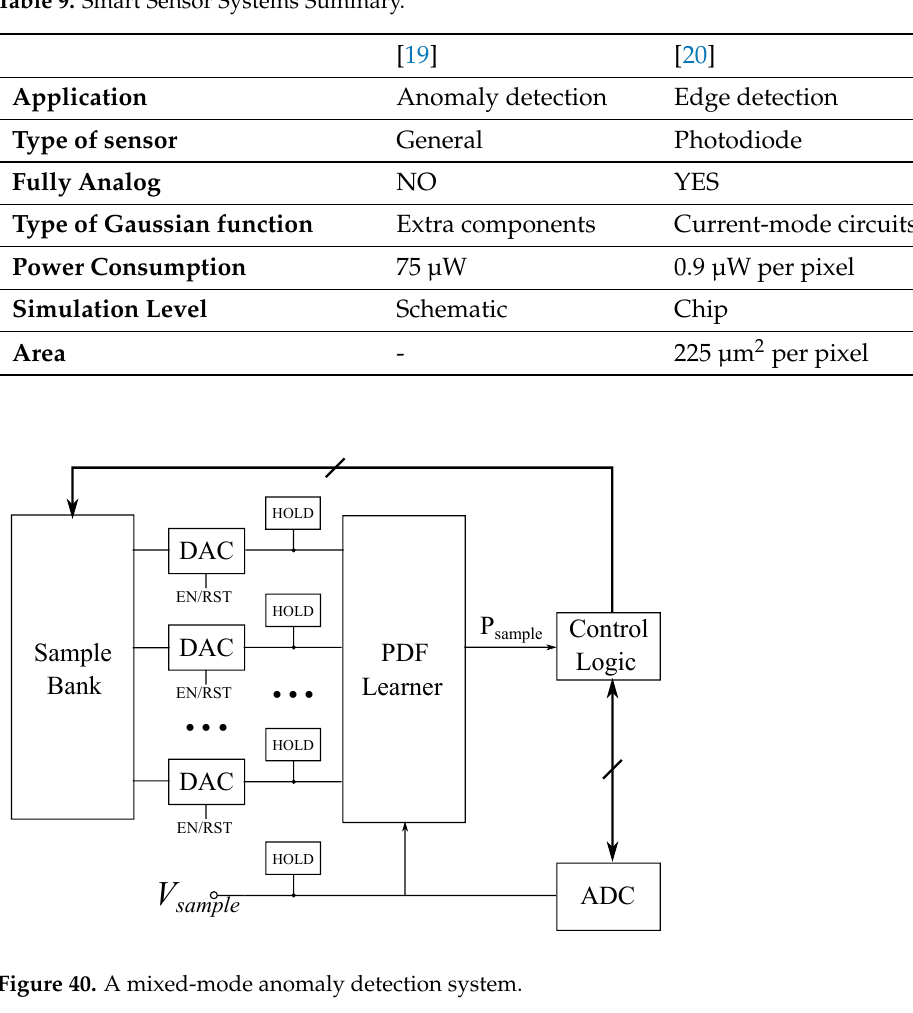
Table 9. Smart Sensor Systems Summary.